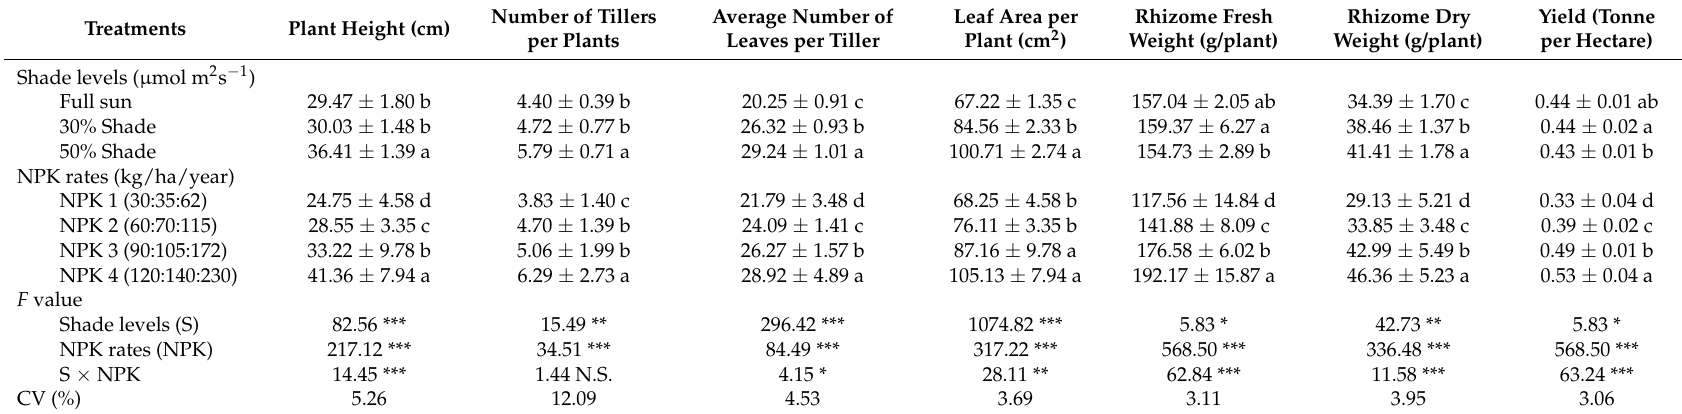
Table 4. Effects of shade levels and NPK fertilizer rates on growth parameters, rhizome fresh weight, rhizome dry weight, and rhizome yield of Z. zerumbet .